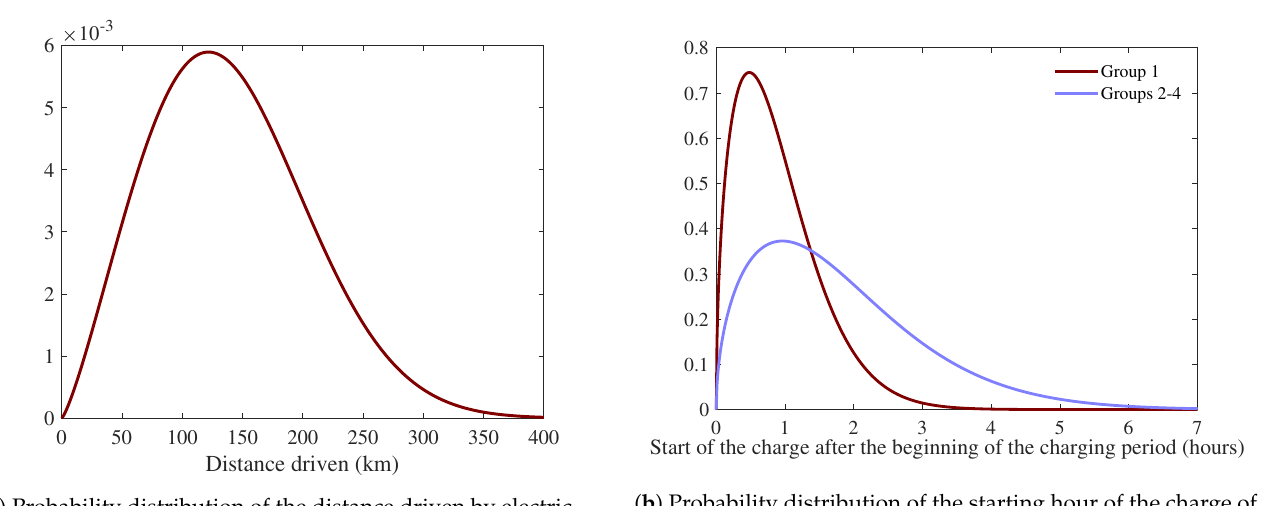
Figure 7. Modeling of the charge of electric vehicles. As an example, Figure 8 represents the two-day aggregated charging profile of a set of 1000 electric vehicles. The charging profile represented in this figure is randomly generated from the distribution functions depicted in Figure 7. Observe that the peak demand is around 750 kW and happens at 2:00 in the two analyzed days. At that hour, a significant part of the vehicles belonging to groups (1) and (2) is charging. Considering that electric vehicles charge at 7.4 kW, around 100 vehicles are simultaneously charging at that hour.